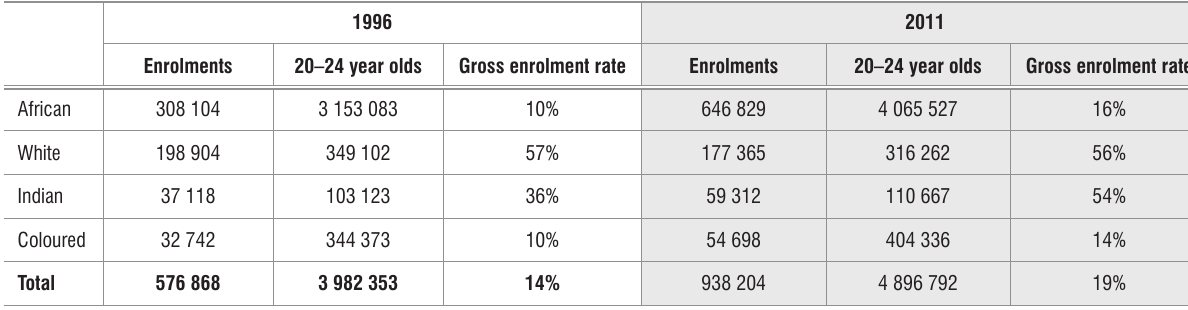
Gross enrolment rates in higher education by race, in 1996 and